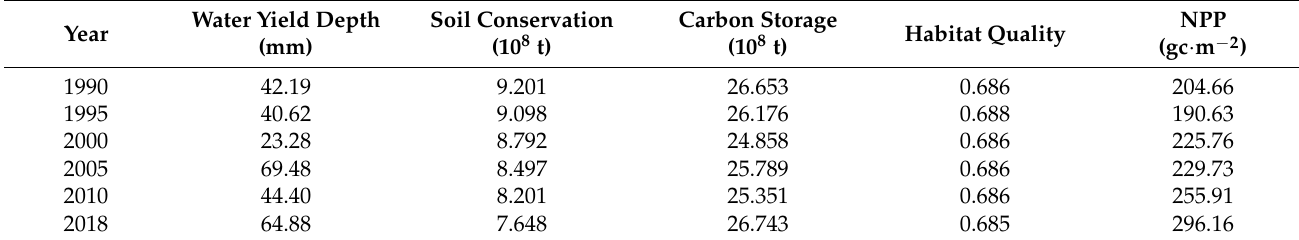
Table 1. Grassland ecosystem functions in the Yellow River